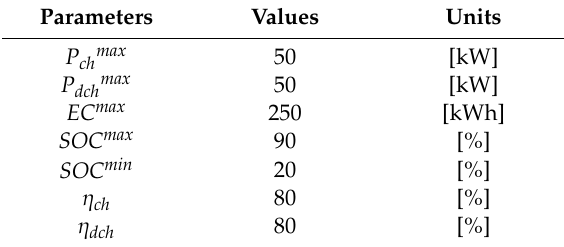
Table 3. Actual energy storage system (ESS) parameters.